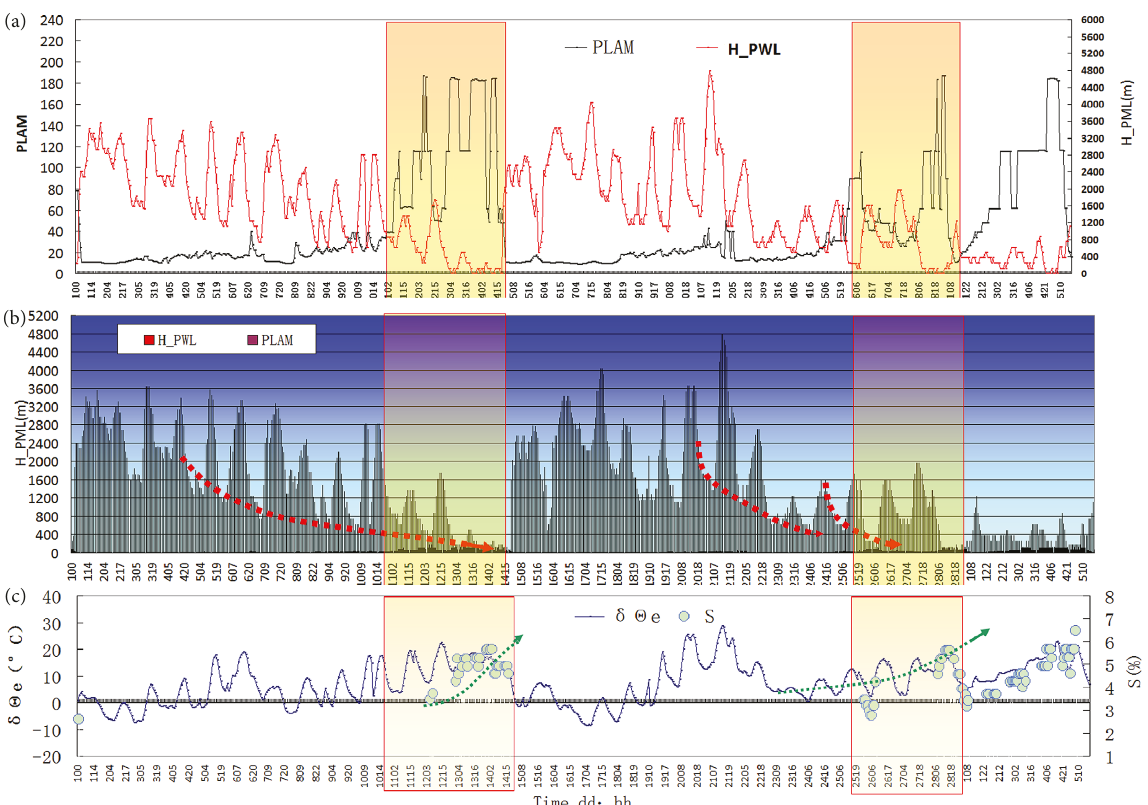
Figure 5: (a) Hourly distribution of PLAM index and height of mixing layer (H_PML) in Beijing in February 2021, (b) distribution of perturbed daily oscillation variation minimum of H_PML and (c) hourly wet potential temperature variation ( δΘ e) and the distribution of atmospheric supersaturation